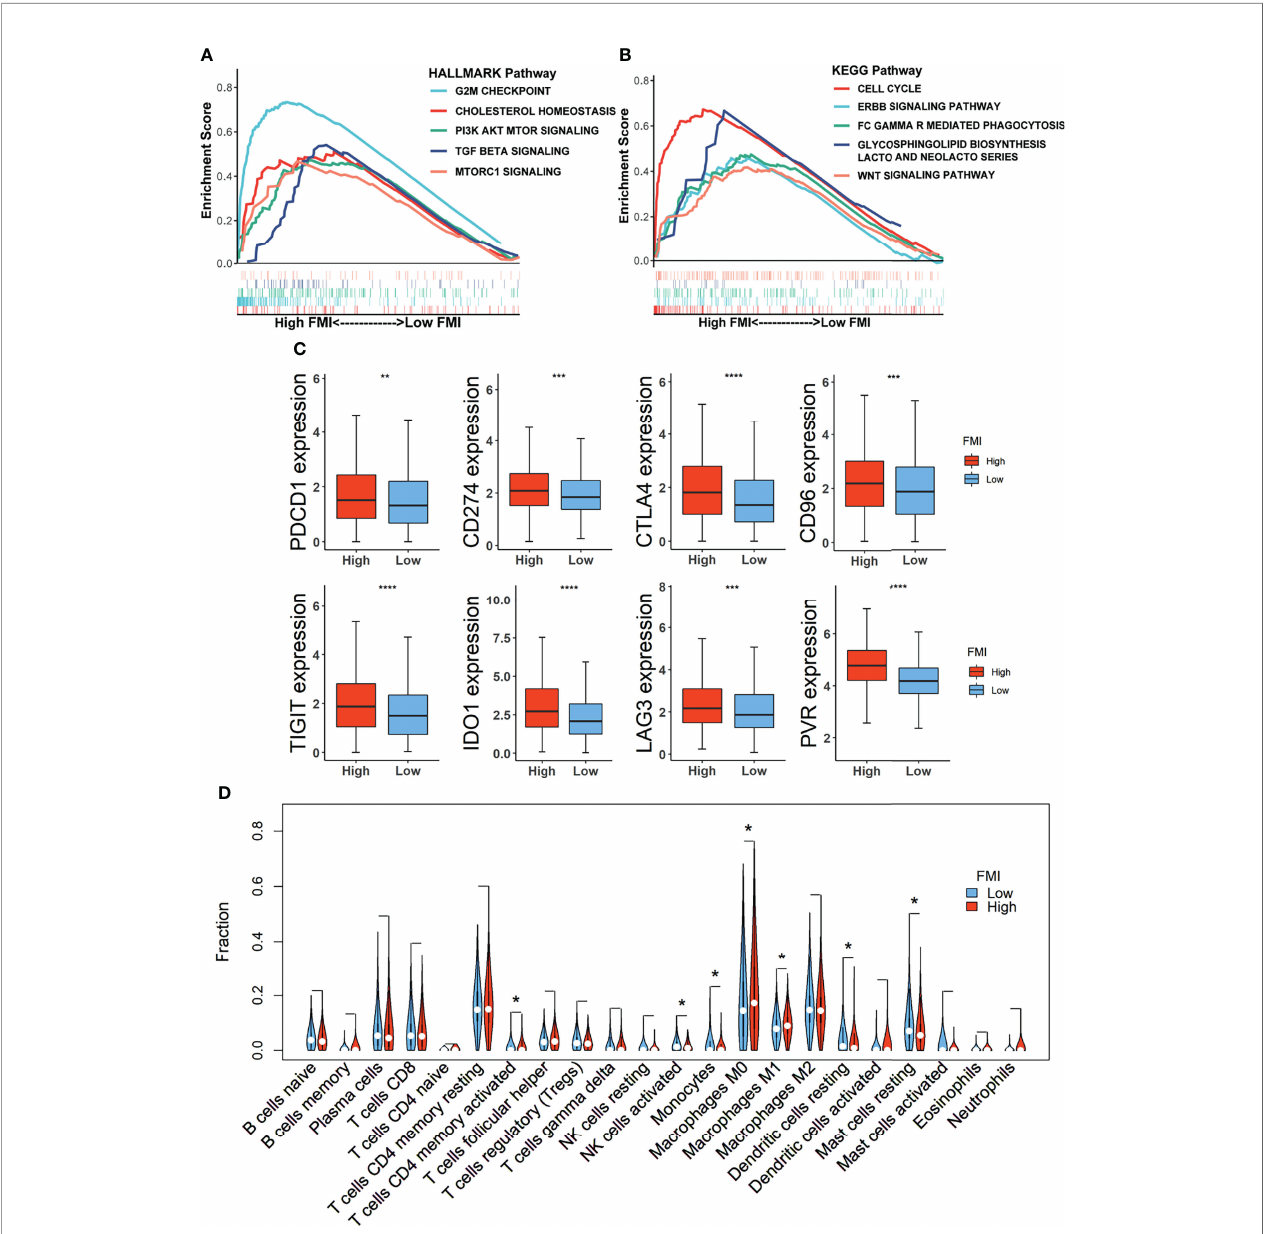
FIGURE 6 | Gene Set Enrichment Analysis (GSEA) and landscape of tumor immune microenvironment between the high- and low-FMI groups. (A, B) Results of GSEA in TCGA-BRCA cohort. (C) Expression level of immune checkpoints in training set. (D) Violin plots of the proportions of 22 immune-in fi ltrating cells in total BC patients. FMI, fatty acid metabolism index; TCGA, The Cancer Genome Atlas; BC, breast cancer. *Means p < 0.05; **means p < 0.01; ***means p < 0.001; ****means p <